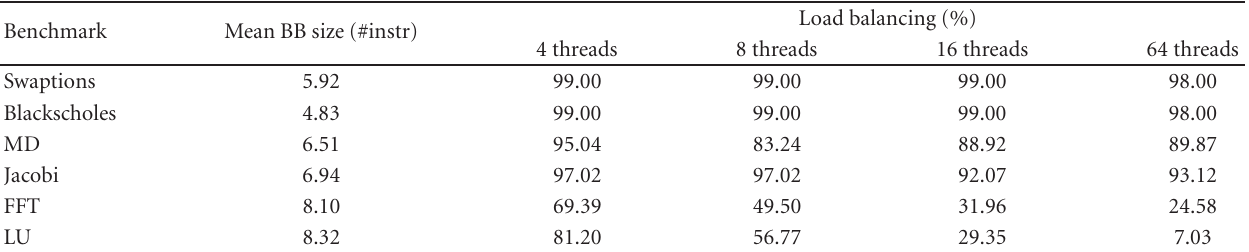
Table 1: ILP and TLP opportunities for the selected benchmarks.